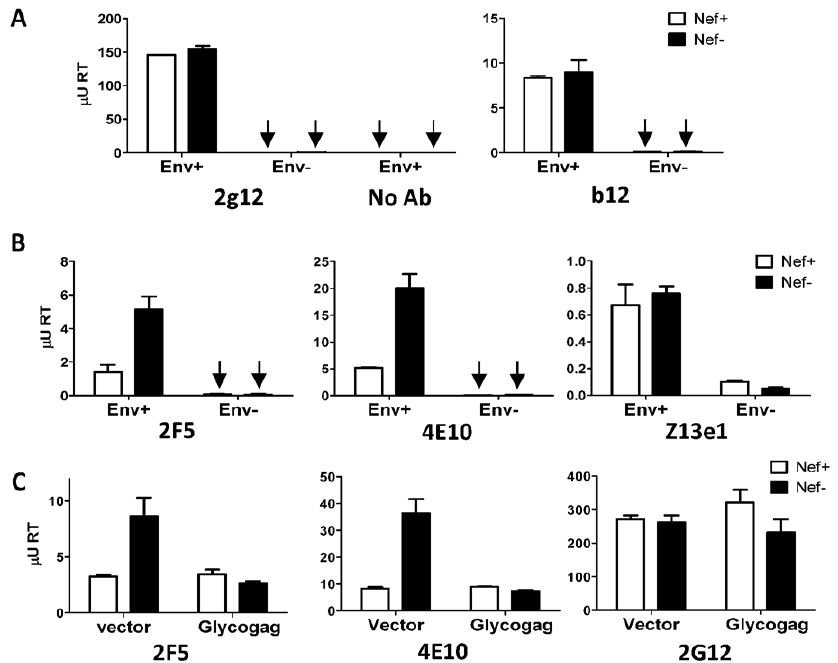
Figure 11. Nef and MoMLV Glycogag specifically alter the capture efficiency of HIV-1 by 2F5 and 4E10. Env JRFL virus pseudotypes (Env + ) captured by magnetic beads conjugated with the indicated antibodies, targeting gp120 (A) or gp41 (B), in the presence or absence of Nef, quantified by RT activity and expressed as m U of HIV-1 RT. C, direct comparison of the abilities of Nef and Glycogag to alter virus capture by 2F5, 4E10 and 2G12. The specificity of the virus capture was assessed by measuring capture of Env-defective virus particles (Env-) by magnetic beads conjugated with each antibody, or capture of Env JRFL pseudotypes by non-conjugated magnetic beads (noAb). Data show average values and standard deviation from triplicate independent